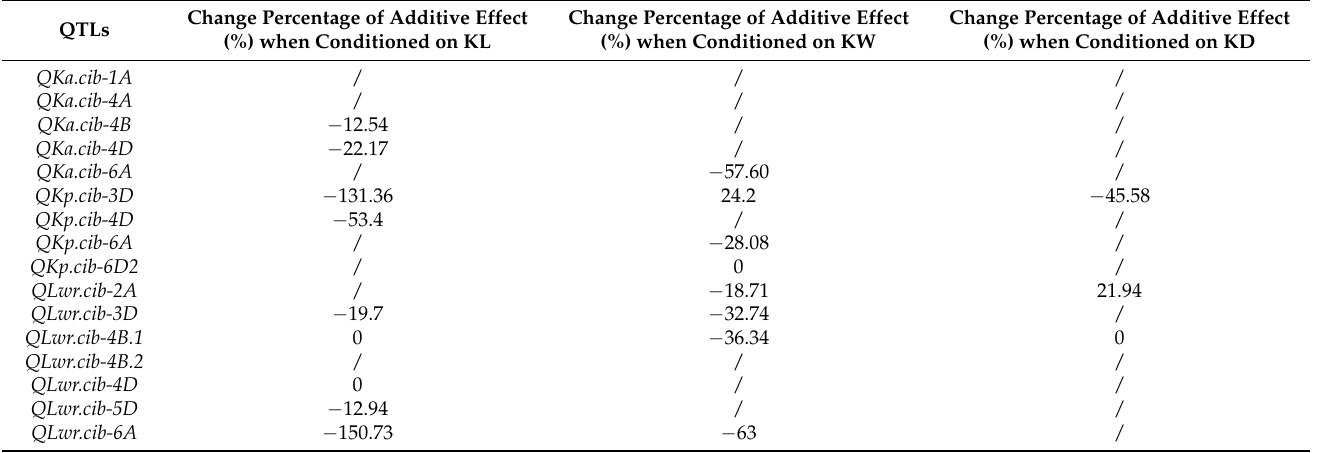
Table 2. The additive effect of QTLs independent of a given KC. Change Percentage of Additive Effect Change Percentage of Additive Effect (%) when Conditioned on KW (%) when Conditioned on